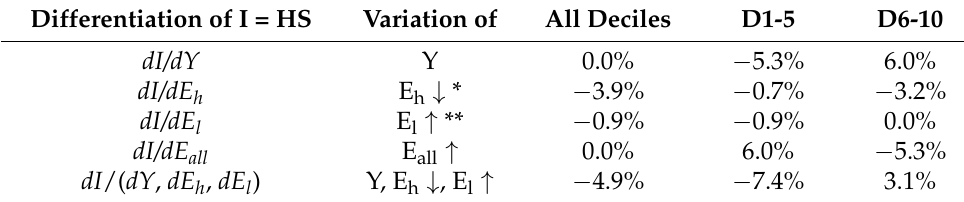
Table 3. Results of sensitivity scenarios for “high share of expenditure/income” (10% change of indicator components).